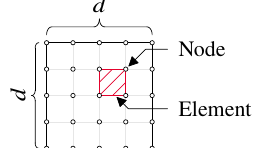
Figure 2. Design space overview with elements, nodes and dimension d (square